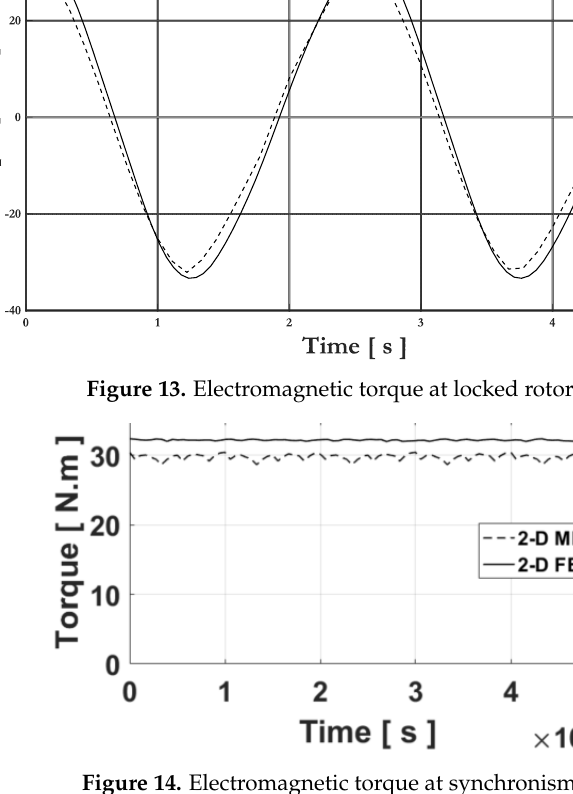
Figure 14. Electromagnetic torque at synchronism.